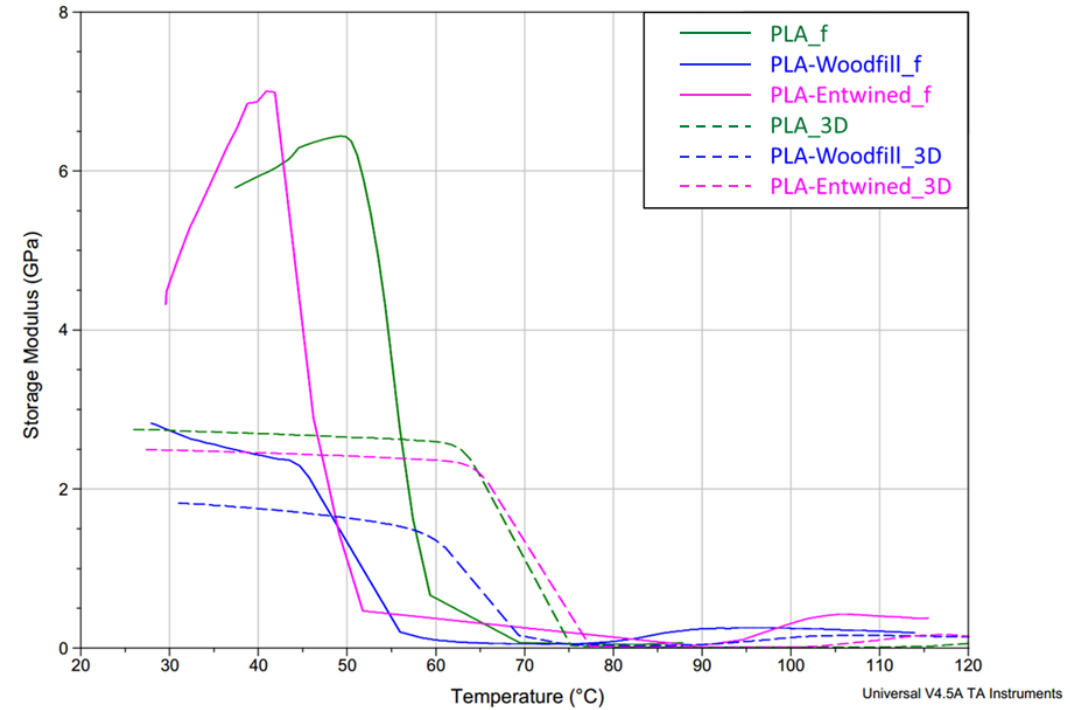
Figure 12. Storage modulus of samples PLA, PLA-Woodfill and PLA-Entwined before and after 3D printing vs. temperature at 10 Hz.